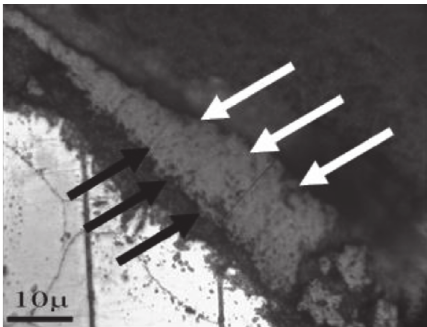
Figure 4: Optical microscopy image of corrosion products on the surfaces of superheater tubes.